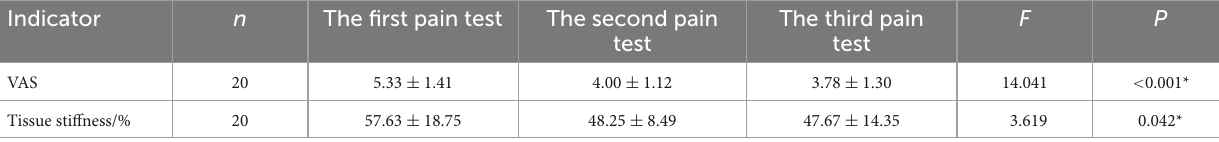
TABLE 3 Comparison of VAS and tissue stiffness for three pain tests.